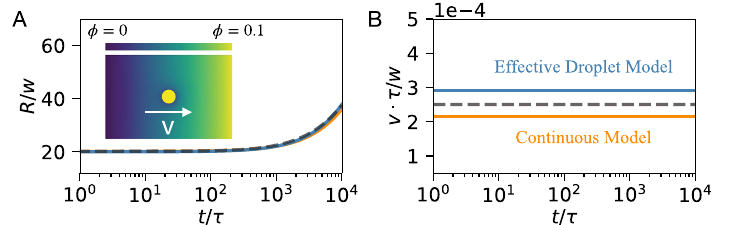
Figure 3. Droplet dynamics in external gradients. ( A ) Droplet radius R as a function of time t compared to the analytical prediction (dashed line) from the thin-interface approximation 27 , the effective droplet model (blue), and the continuous model (orange). The inset shows a schematic of the simulation with the gradient imposed in the background. ( B ) Droplet drift speed v as function of t compared to the analytical prediction (dashed line) from the thin-interface approximation 27 . ( A , B ) The continuous model uses a cylindrical domain with r 0, 400 w L 2 , L 2 600 w , azimuthal symmetry, and boundary conditions µ( z , z with L 2 ∈ [ ] ∈ [− ] = L 2 ) 0.072 bw 3 to impose the gradient. The effective model uses a 3-dimensional box of size and µ( z = = 3 with L L 3 , L 3 3 = 422 w , (cid:31) x = R 0 , ℓ ≈ � s ≈ R 0 , and boundary conditions φ out ( y = − L 3 ) = 0.01483 [− ] and φ out (